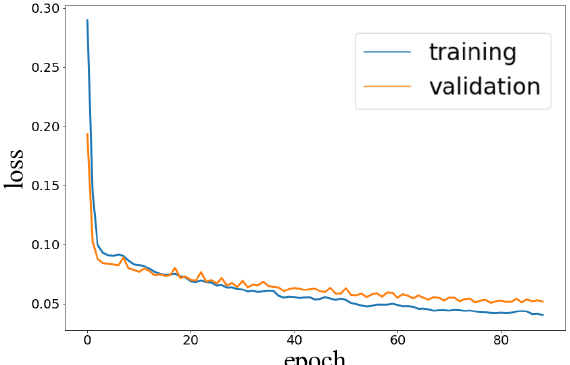
Figure 5. Performance of LSTM during training.